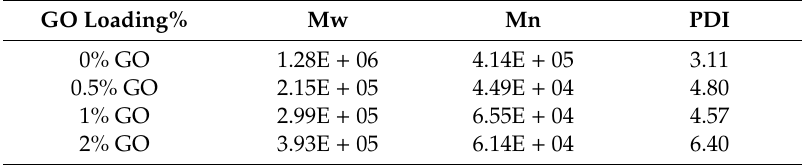
Table 2. The molecular weight of polymerized latex of PMMA with di ff erent GO loading